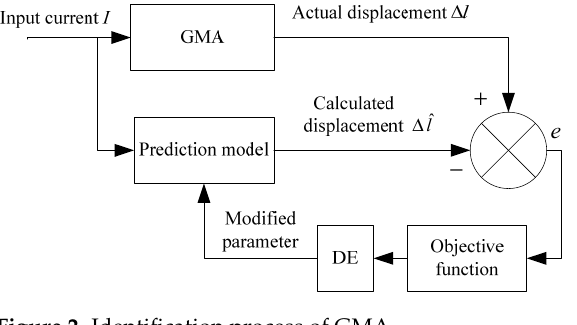
Figure 2. Identification process of GMA.